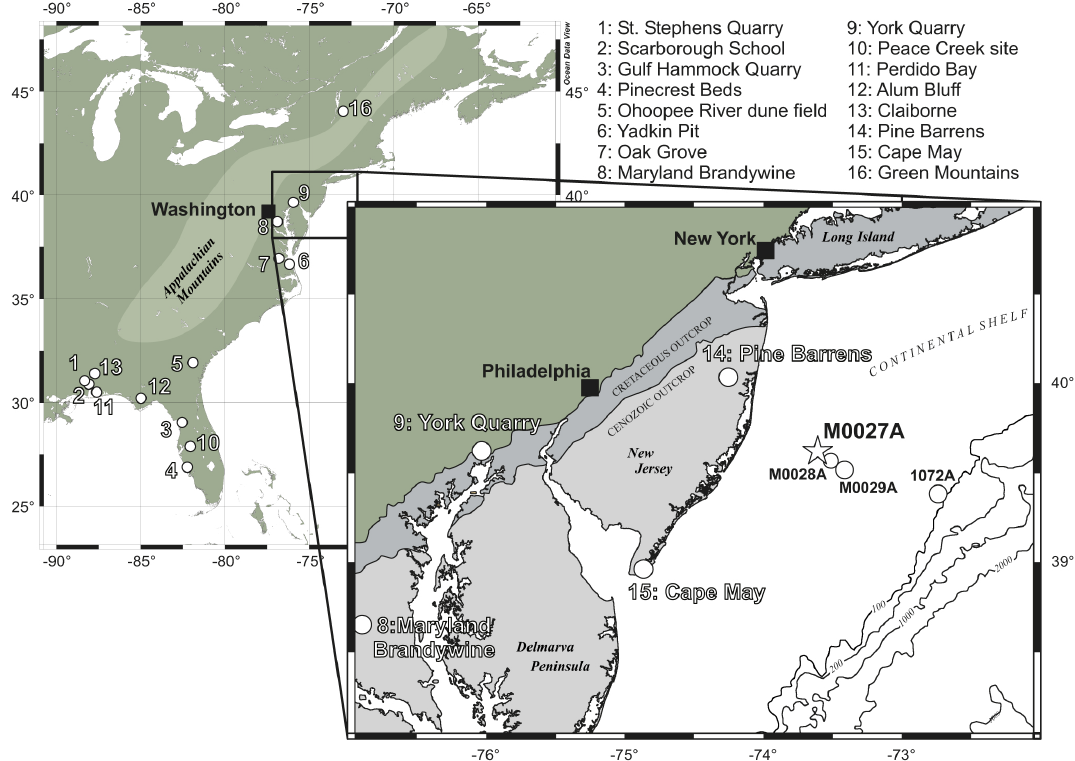
Figure 1. Map of eastern North America with a zoom into the area around New Jersey. White points indicate plant macrofossil outcrops, pollen profiles, and drilling sites referred to (1: Oboh et al., 1996; 2, 10, 11: e.g. Stults et al., 2010; 3, 8, 12: e.g. Jarzen et al. 2010; 4: Hansen et al., 2001; Jarzen and Dilcher, 2006; 5: Rich et al., 2002; 6: Groot, 1991; 7: Frederiksen, 1991; 9: Pazzaglia et al., 1997; 13, 14, 15: e.g. Rachele 1976; 16: Traverse, 1994) and the white star indicates the position of Site M0027 (after Mountain et al., 2010; Schlitzer, 2011). Black squares mark the position of major